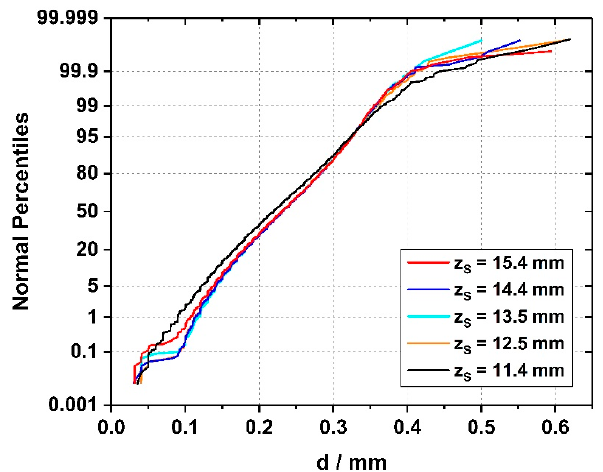
Figure 14. Cumulative frequency curves (probability plots) of dendrite spacings retrieved from five complete tomographic cross sections of the SX bar. Over 7000 individual spacings (one dendrite has several neighbors) were evaluated for each z S position/tomographic slice.